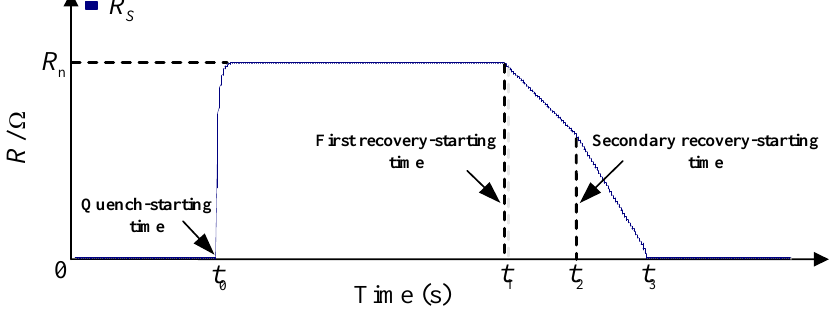
Figure 7. Quench/recovery of the SC used in the SFCL.